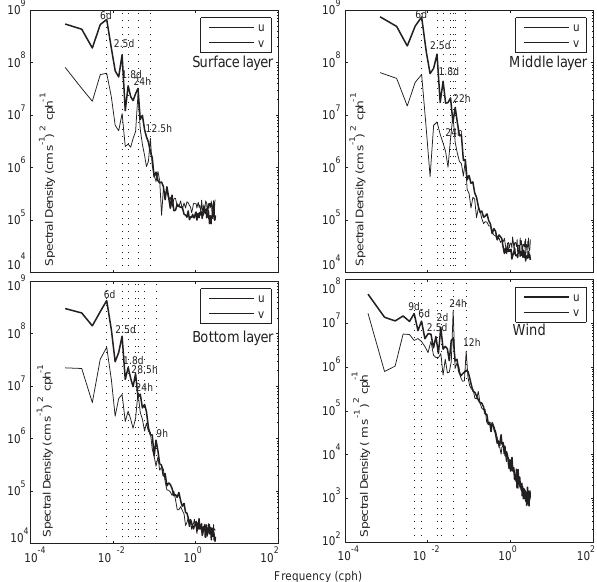
Fig. 8. Power spectral density of the alongshore (348 ◦ N, thick line), and cross-shore (78 ◦ E, thin line) components of the wind and current based on hourly filtered data sets for whole recording period during August and September